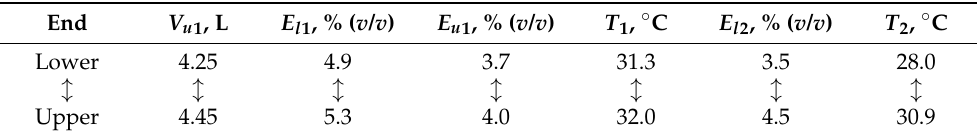
Table 9. Upper and lower end of the ranges over which the operational variables maximized 𝑃 𝑚 𝑒𝑠𝑡 .